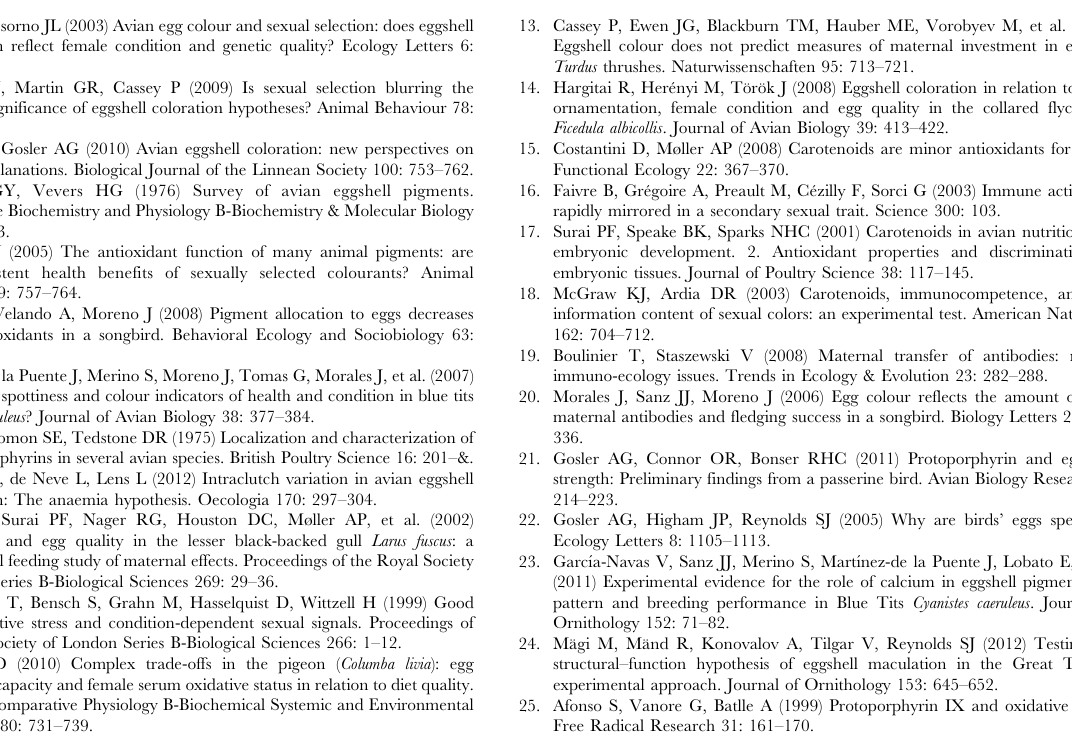
Table S2 Full models of yolk antibody concentration in relation to egg, female, and male traits. (DOC) Table S3 Full models of yolk carotenoid concentration in relation to egg, female, and male traits. (DOC) Methods S1 Plumage coloration by spectrometry. Results S1 The predictors of yolk